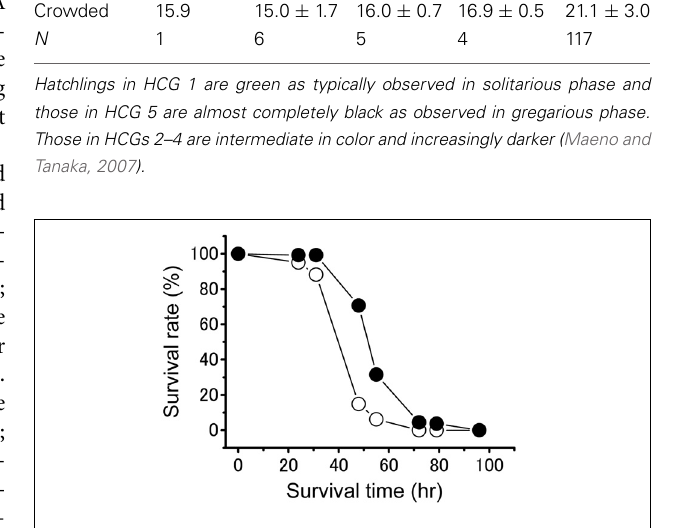
FIGURE 4 | Survival rate of the solitarious hatchlings (open circle, dotted line: from isolated-reared females) and gregarious ones (closed circle, solid line: from crowd-reared ) in Schistocerca gregaria under starvation conditions. Sample size is 161 in the solitarious hatchling group and 133 in the gregarious hatchling group. A Kaplan-Meier test showed a significant difference between the two time series at P < 0 .